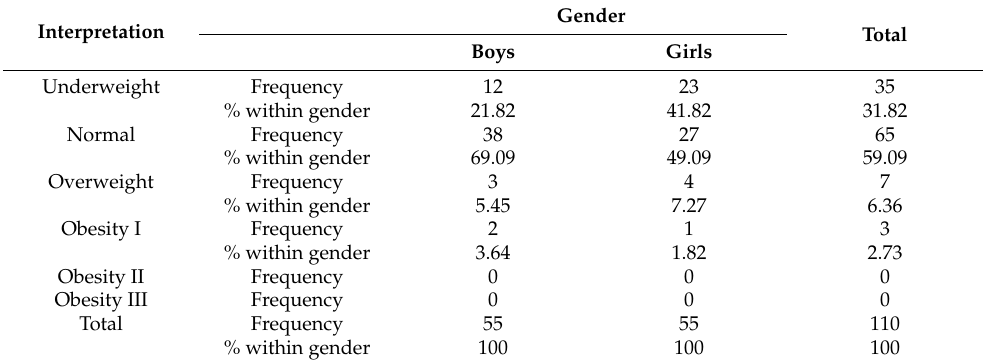
Table 4. Body mass index (BMI) of the Syrian participants ( n = 110) according to WHO classification.